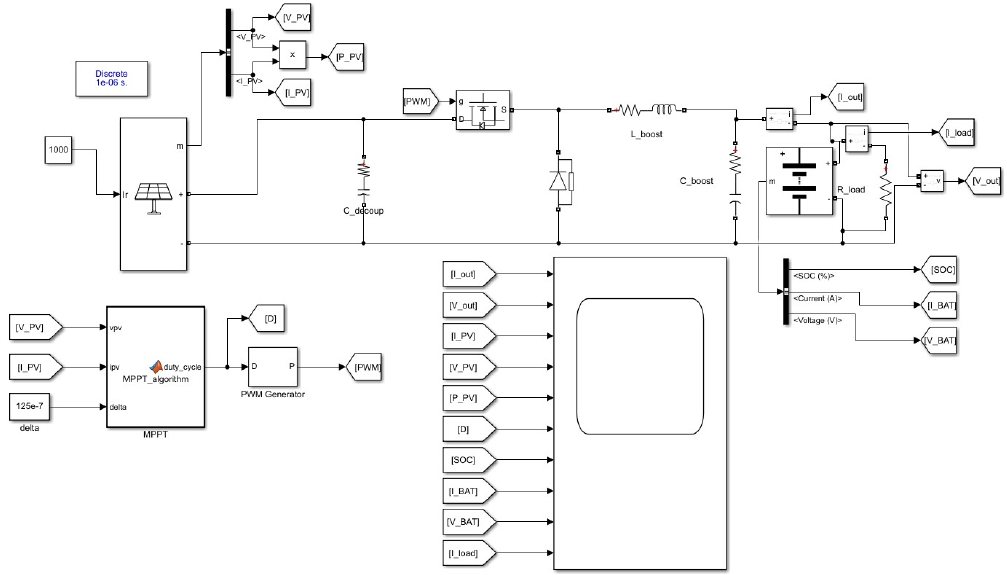
Figure 31. Simulink model of the MPPT with a solar array, buck converter, battery and load. Usually, the design of a DC-DC converter is based on a required duty cycle and volt- age and current ripples, so that for a given switching frequency ( f sw ) the capacitance and inductance can be calculated. For this application, it is not sensible to use such an ap- proach. The output ripples will be much lower, as the charging element is the battery, with a much higher response time than the rest of the components of the buck converter, disregarding the need for high frequency switching. For these reasons, a trial and error approach is executed with this model. Figures 32 and 33 show the final solar array output power of this model. Figure 32. Solar array output power for 3 different decoupling capacitance values.